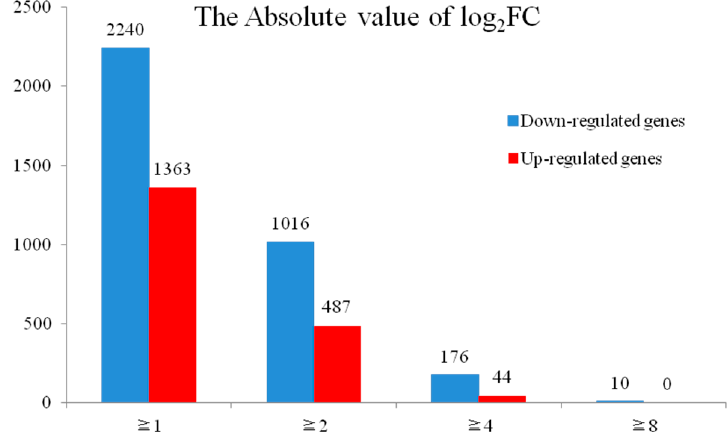
Figure 4. Distribution of the differentially expressed genes (DEGs) between H276A and H276B identified using different fold-change thresholds.